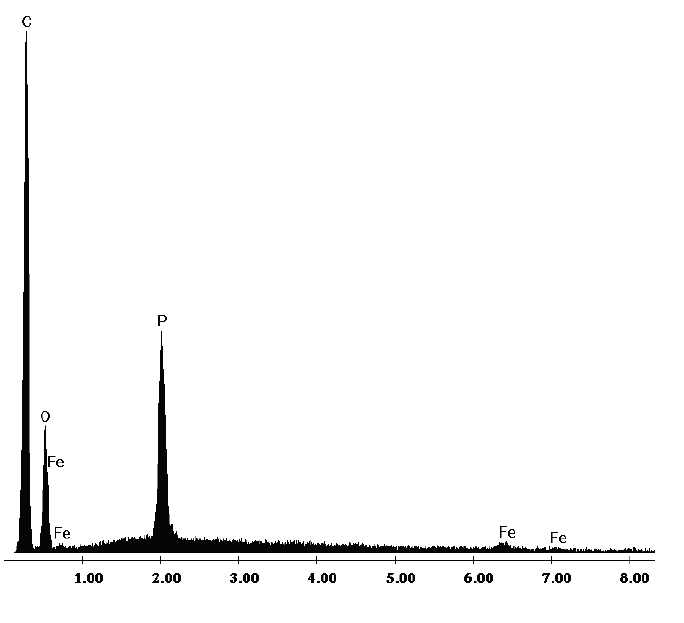
Figure 3. EDX spectrum of Fe-XAD8-DEHPA